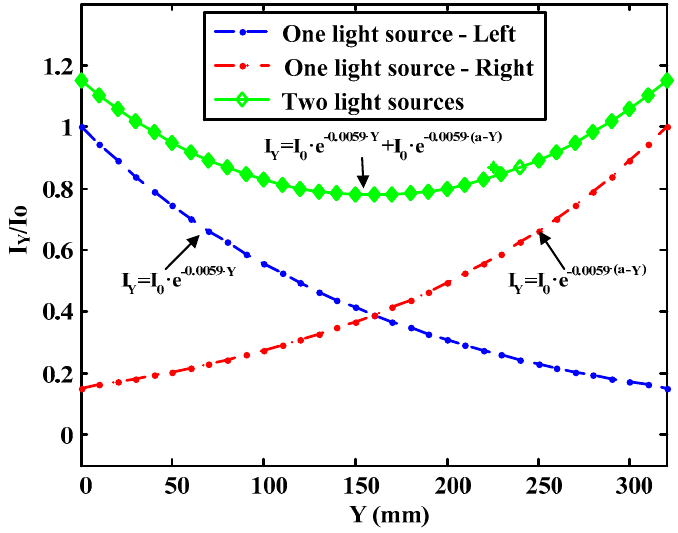
Figure 11. Transverse absorption of light vs. source/s location.